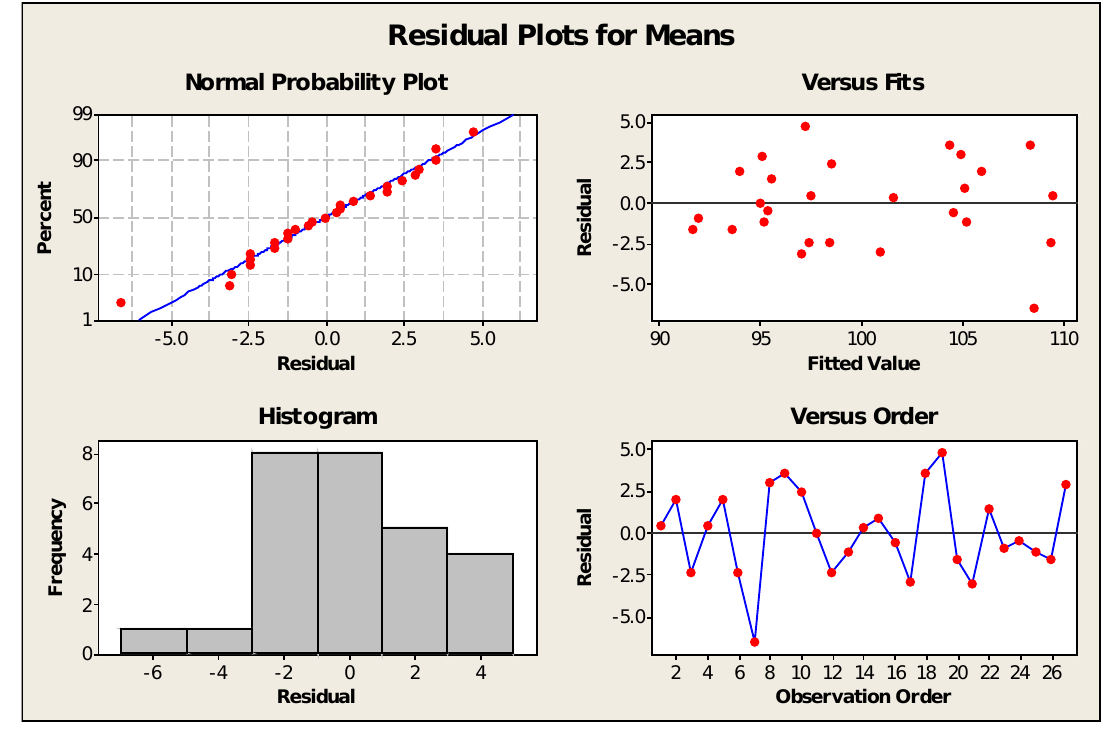
Fig. 5. Residual Plots for